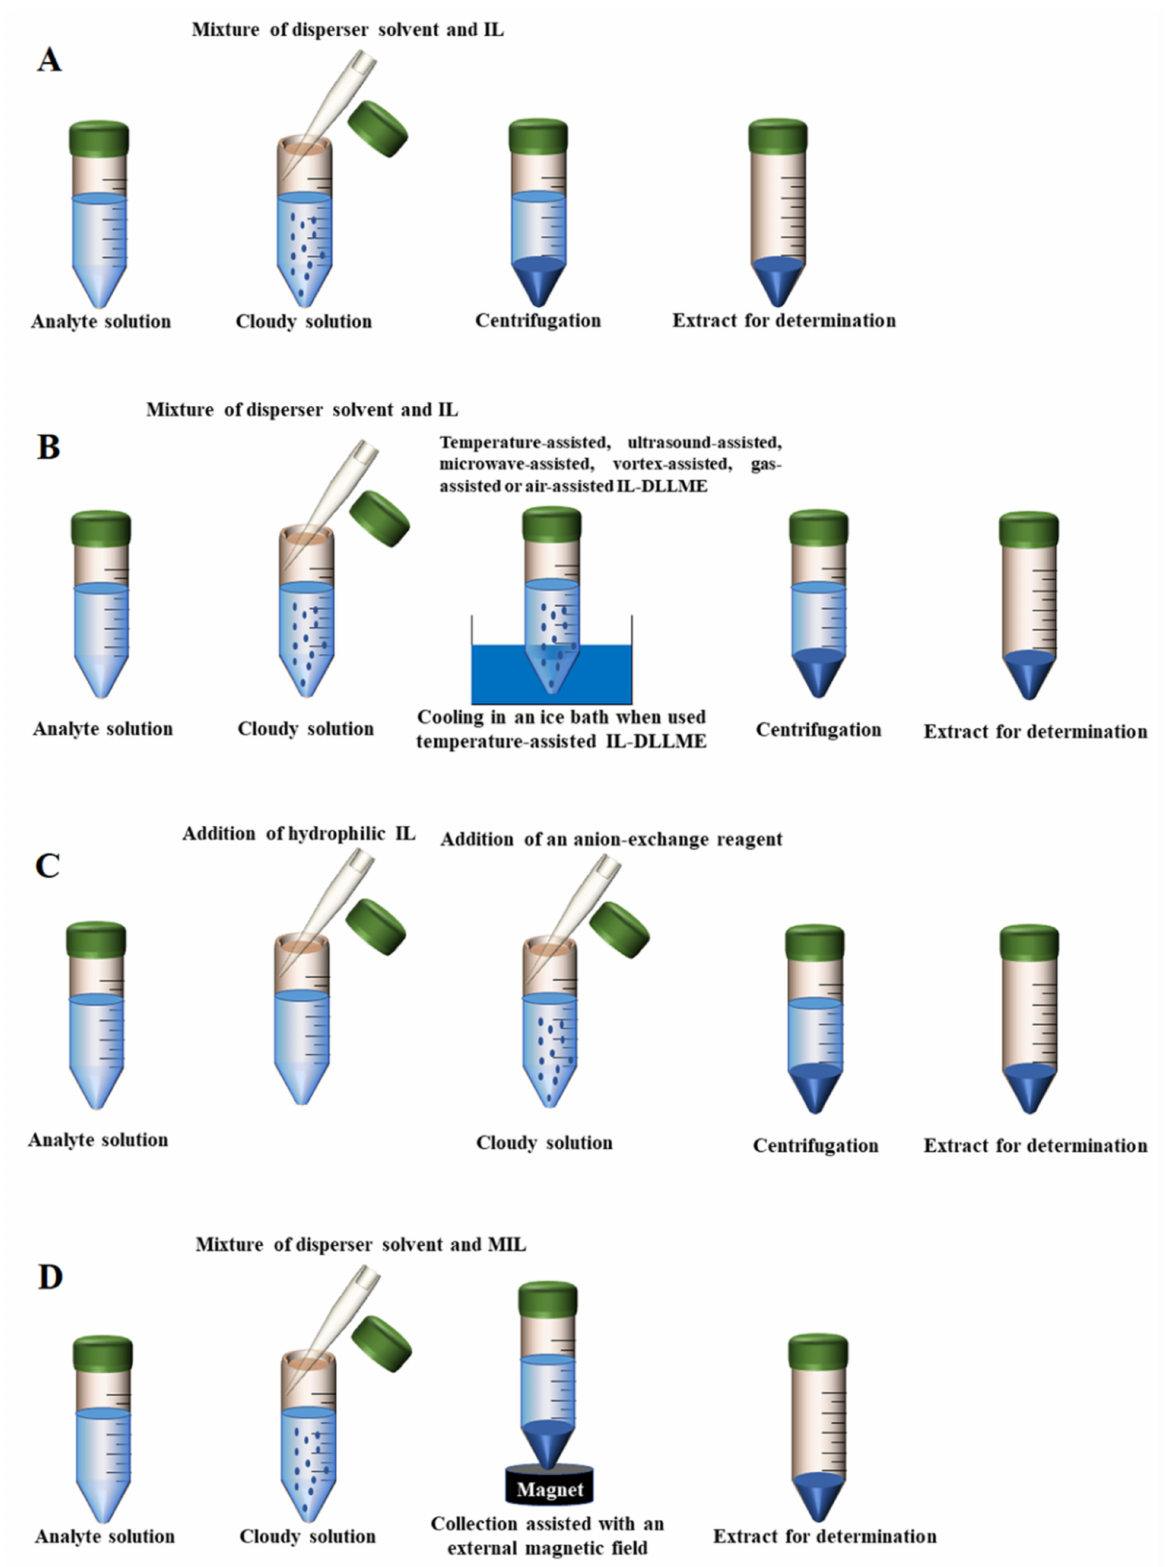
Figure 2. The scheme of different DLLME modes. ( A ) Conventional IL-DLLME; ( B ) External assisted IL-DLLME; ( C ) in situ IL-DLLME; ( D )